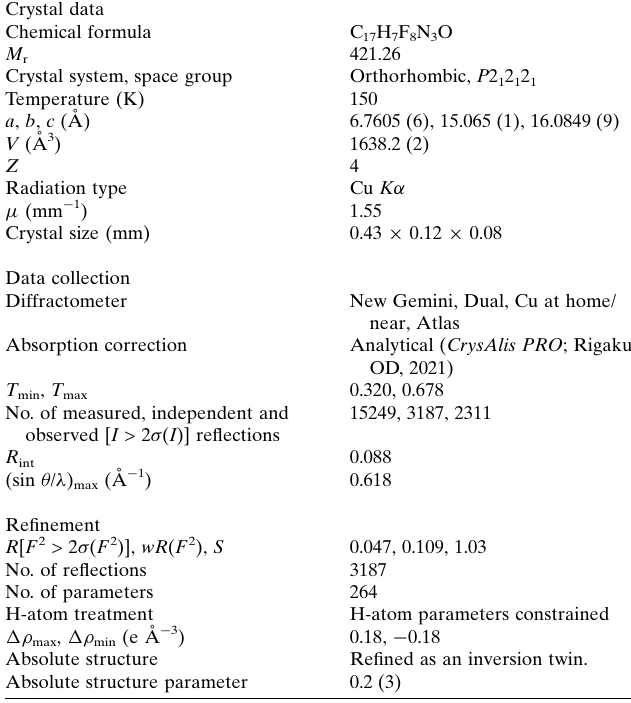
Crystal data Chemical